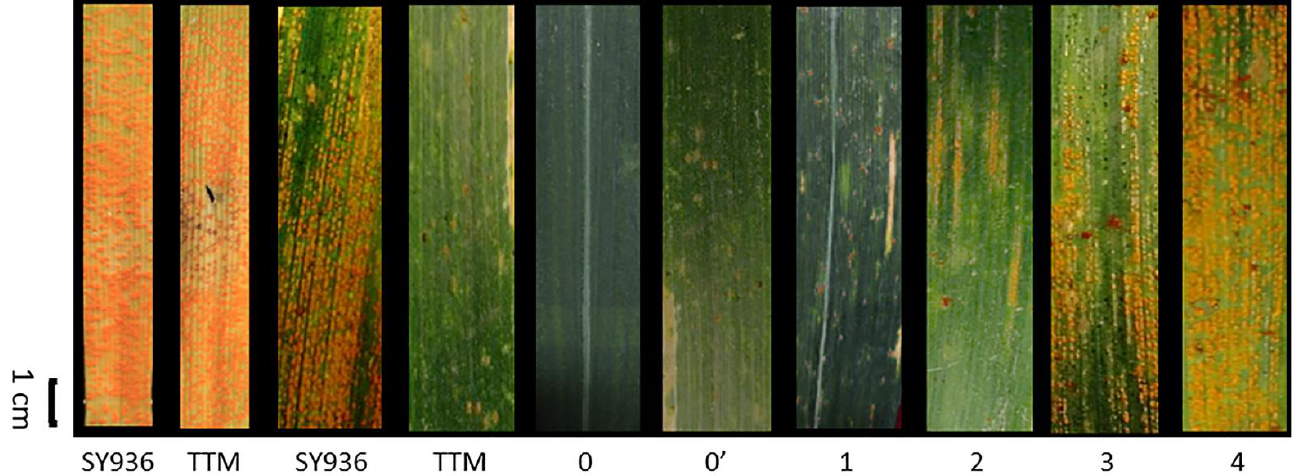
Figure 1. Infection types (ITs) of stripe rust resistance for parents and recombinant inbred lines (RILs). From left are yellow rust (YR)-inoculated leaves, showing YR symptoms on the parents SY936 and TTM at the seedling (leaves 1 – 2) and adult-plant stages (leaves 3 – 4), and the recombinant inbred lines, with an IT of 0 (immune), 0’ (near immune), 1 (highly resistant), 2 (moderately resistant), 3 (moderately susceptible), and 4 (highly susceptible) at the adult stage. Table 1. Analysis of variance of the three stripe-rust-resistance traits evaluated at the adult-stage under four